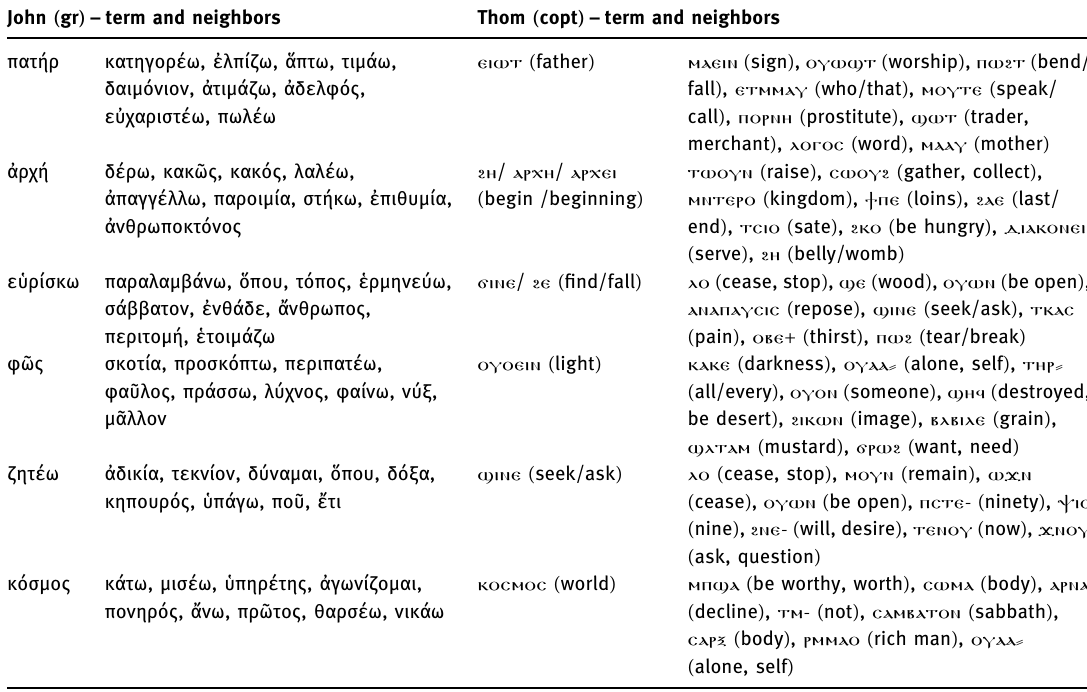
Table 1: Target terms ’ nearest neighbors in Greek and Coptic John ( gr ) – term and neighbors Thom ( copt ) – term and